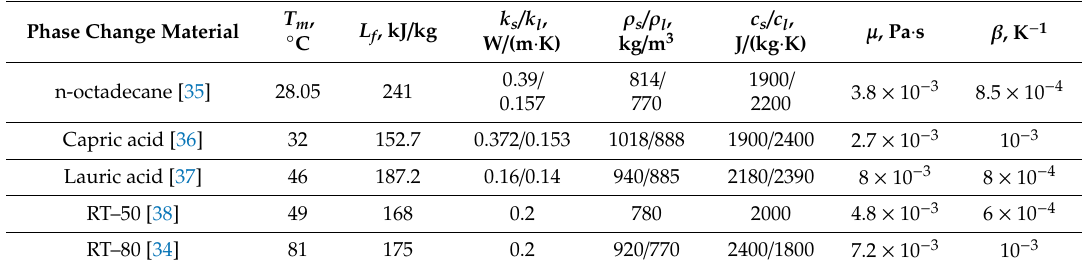
Table 2. Properties phase change